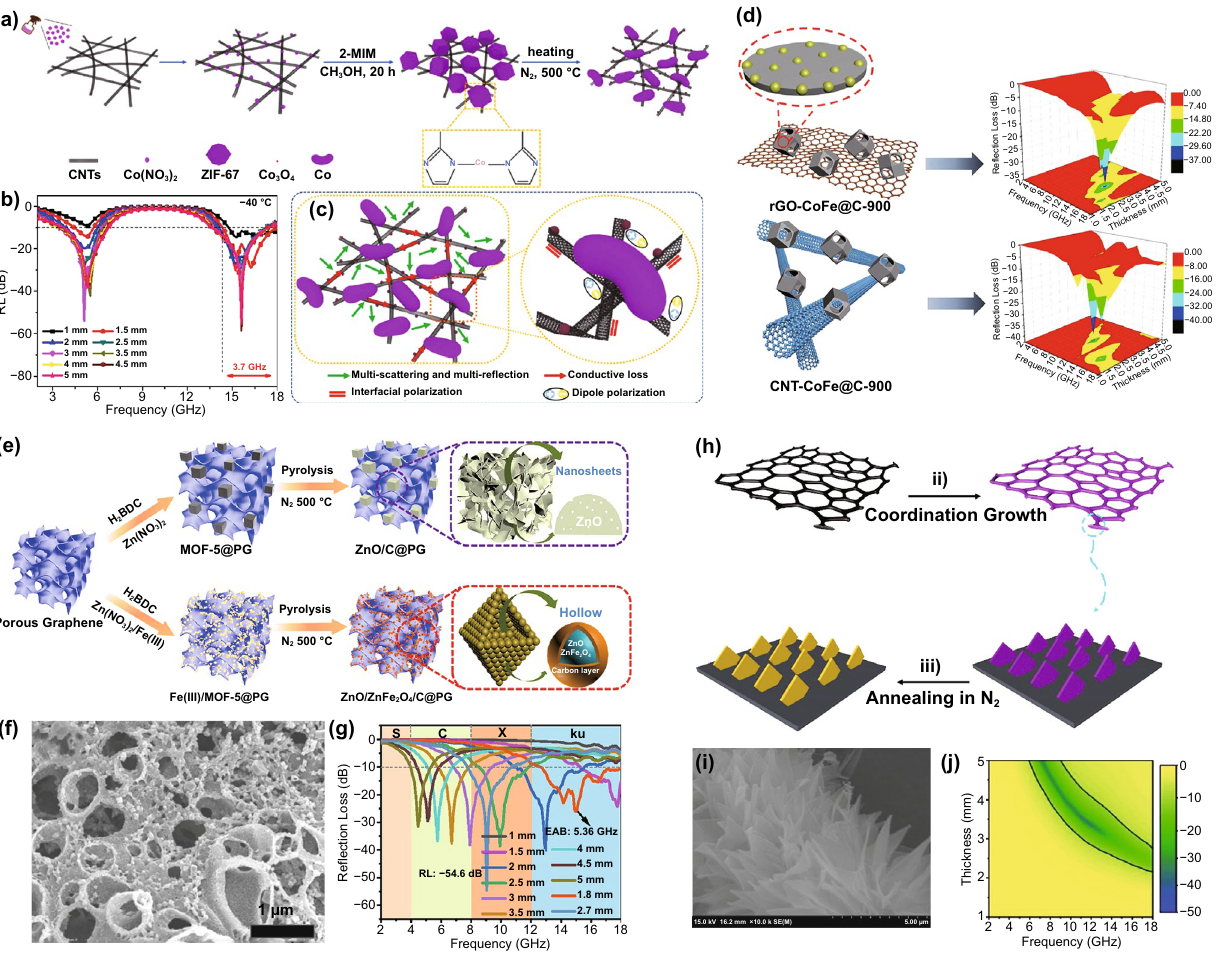
Fig. 14 a Schematic illustration of the synthesis b RL-f curves and c MA mechanism of Co-based MOF-derived carbon/CNTs. Reprinted with permission from Ref. [135]. d Schematic illustration of preparation and RL-f curves of rGO-CoFe@C and CNT-CoFe@C. Reprinted with per- mission from Ref. [77]. e Schematic illustration of the synthesis of ZnO/C@PG and ZnO/ZnFe 2 O 4 /C@PG. f SEM image and g RL-f curves of ZnO/ZnFe 2 O 4 /C@PG. Reprinted with permission from Ref. [45]. h Schematic illustration the synthesis. i SEM image and j 2D RL projection mapping of Co 3 O 4 /CF. Reprinted with permission from Ref.